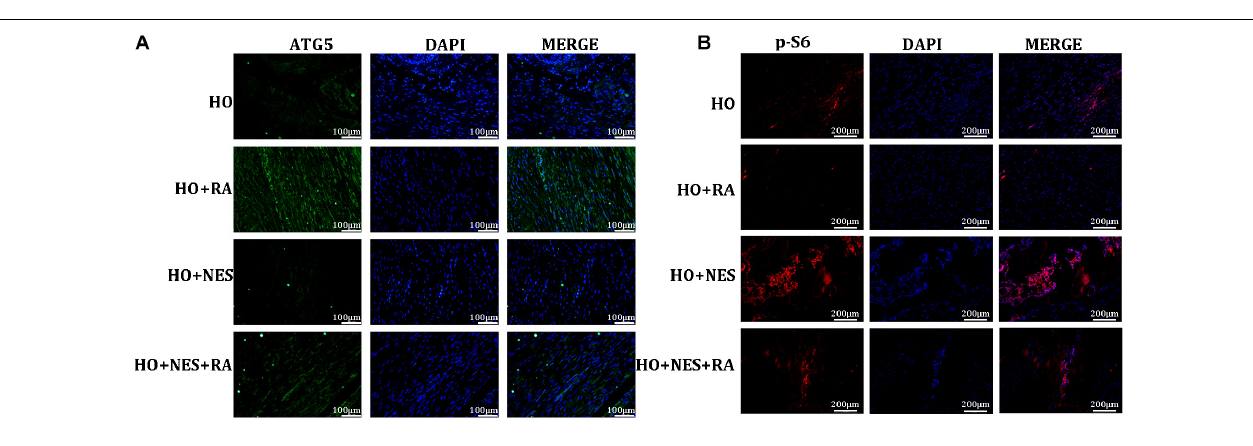
Frontiers in Cell and Developmental Biology |